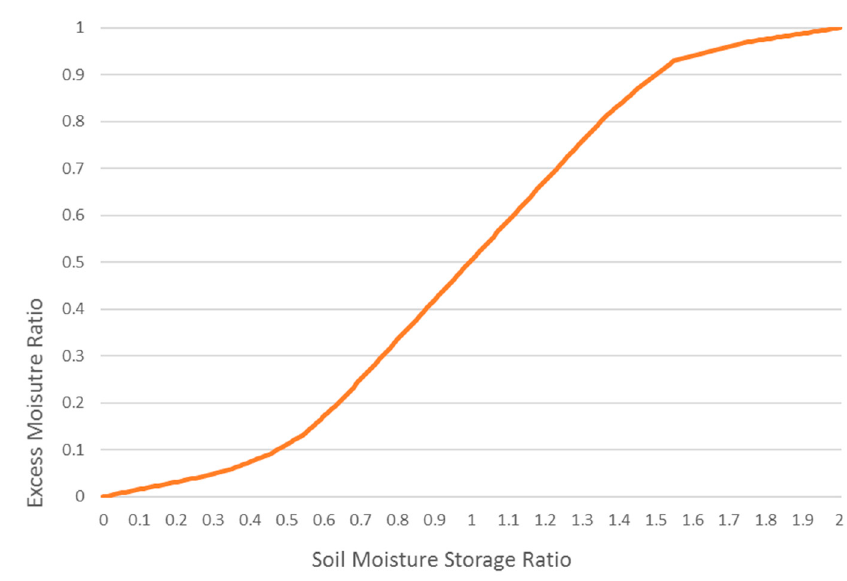
Figure 5. Soil moisture storage ratio/Excess moisture ratio.